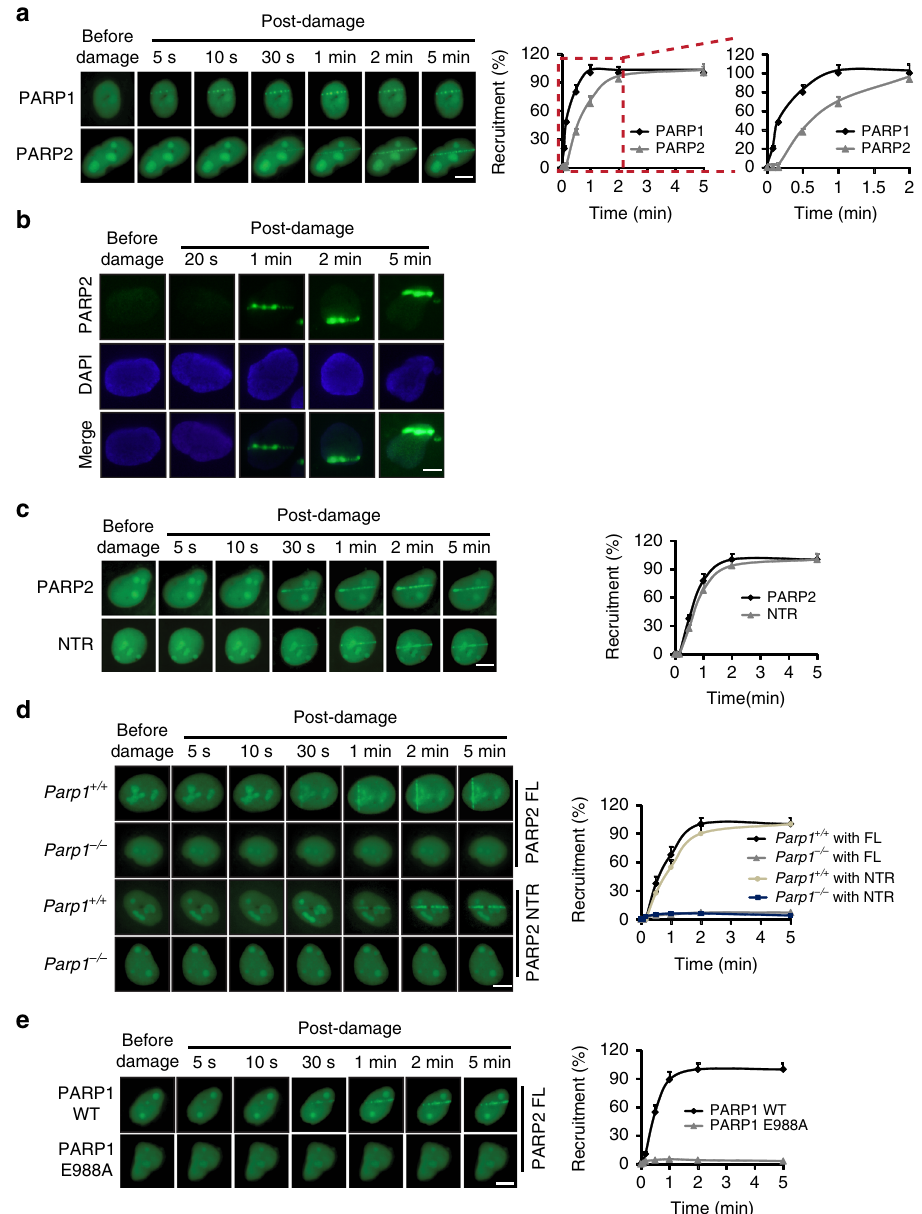
Fig. 4 The recruitment of PARP2 to DNA lesions is mediated by PARP1-dependent PARylation. a The recruitment kinetics of PARP2 to DNA lesions. GFP- PARP1 or PARP2 were expressed in U2OS cells. Following laser micro-irradiation treatment, the recruitment of PARP1 or PARP2 was examined with live- cell imaging at the indicated time points (left panel). The relocation kinetics is shown in the right panel. Data represent mean ± s.d. from three biologically independent experiments (right panel). At least 20 cells were included in each experiment. b The recruitment of endogenous PARP2 was examined following laser micro-irradiation by anti-PARP2 antibodies. c The NTR domain alone is suf fi cient to be recruited to the DNA damage sites. The recruitment kinetics of GFP-NTR at different time points was measured. d PARP1 is required for the recruitment of PARP2. GFP-PARP2 or the NTR domain was expressed in the Parp1 + / + or Parp1 − / − MEFs. The recruitment kinetics was examined at indicated time points. The percentage of recruitment under different PARP1 conditions is shown in the right panel e . The catalytic activity of PARP1 is required for the recruitment of PARP2. PARP1-de fi cient U2OS cells were stably expressing the full length PARP1 or the E988A mutant (catalytic inactive mutant). GFP-PARP2 was expressed in the cells, and the recruitment kinetics was measured. Scale bar represents 5 μ